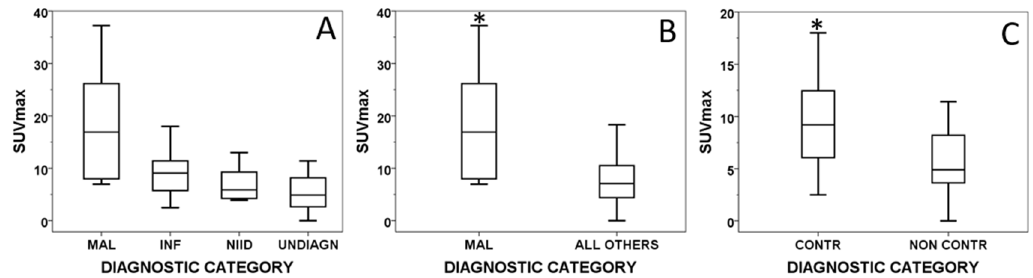
Figure 1. Box plot graphs showing SUVmax distribution in various diagnostic categories. Across the four groups of final diagnosis ( A ); between malignancy and non-malignancy ( B ) and between contributory and non-contributory scans ( C ). SUVmax, maximum-standardized uptake value; NIID, non-infectious inflammatory disease; MAL, malignant; INF, infectious; NIID, non-infectious inflammatory disease; UNDIAGN, undiagnosed; CONTR, contributory; NONCONTR, non- contributory; * p < 0.05.